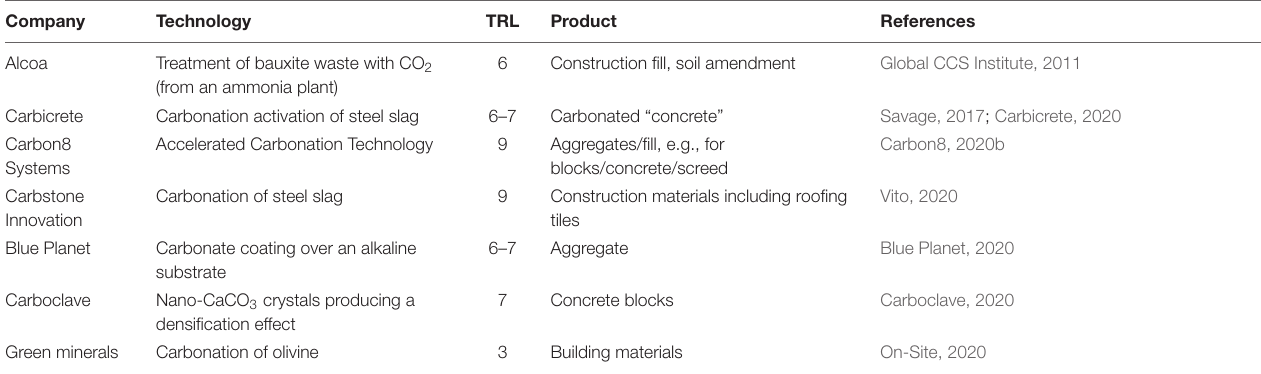
TABLE 3 | Selected mineralization processes yielding construction products.